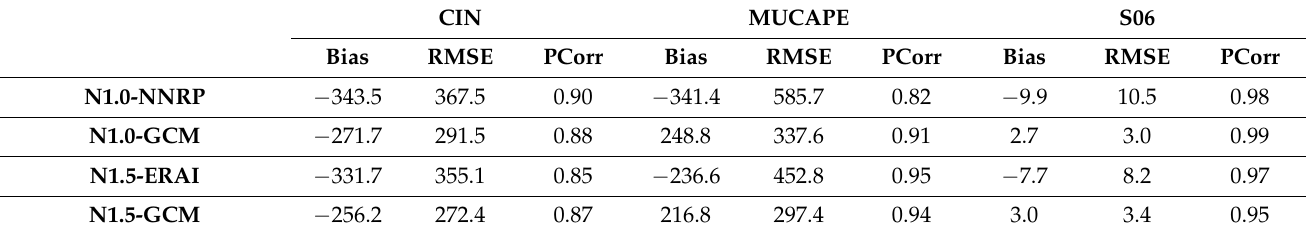
Table A2. Mean annual bias, RMSE and PCorr for the indices CIN, MUCAPE and S06 simulated in the CORDEX (d01) domain by the reanalysis-driven and GCM-driven N1.0 and N1.5 ensemble mean. Unit: J kg − 1 for CIN and MUCAPE and m s − 1 for S06. The PCorr values are all significant at the 0.01 confidence level.